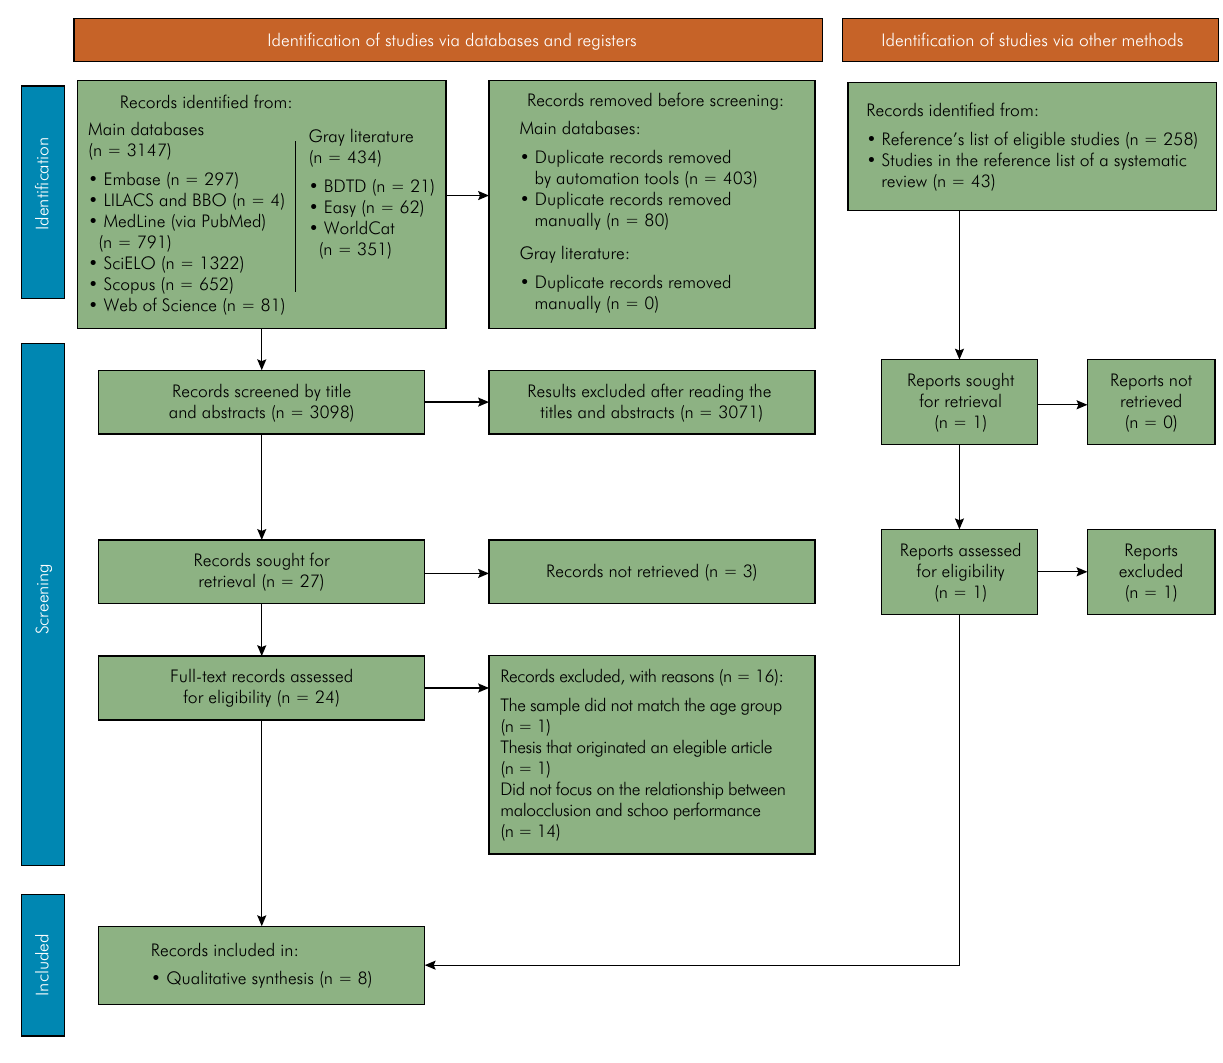
Figure. Flowchart depicting the study selection process (Preferred Reporting Items for Systematic Reviews and Meta-Analyses flow